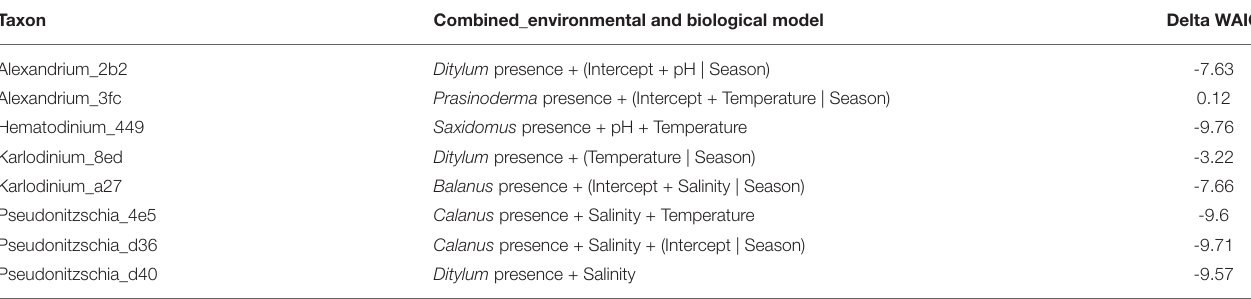
TABLE 3 | Terms of the best-fit models combining environmental variables and most closely associated biological taxon for eight focal algal lineages.